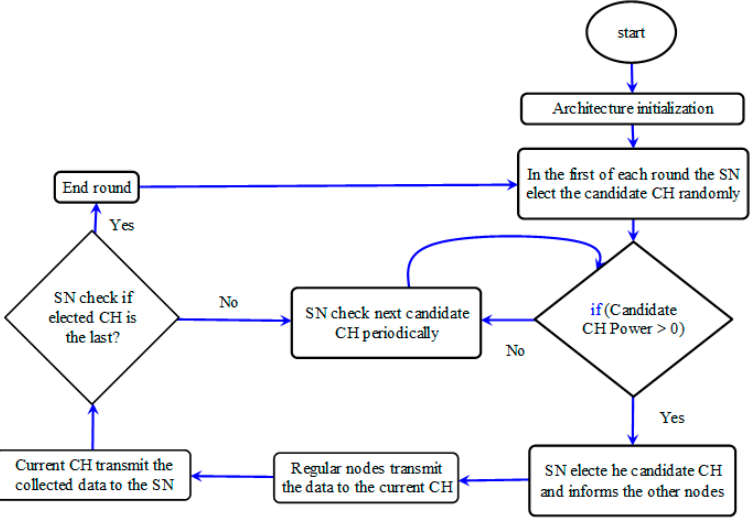
Figure 5. The proposed Optimum Cluster Head Election method’s data flow